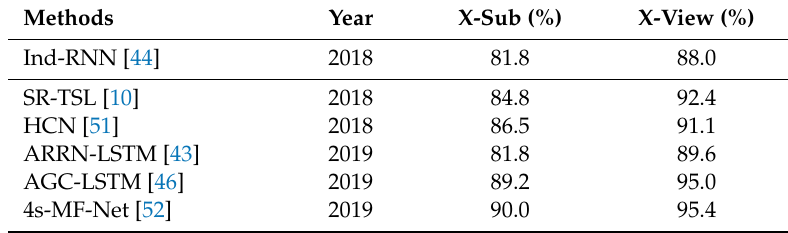
Table 6. The accuracy comparisons with state-of-the-art methods on the NUT-GRB + D 60 dataset.